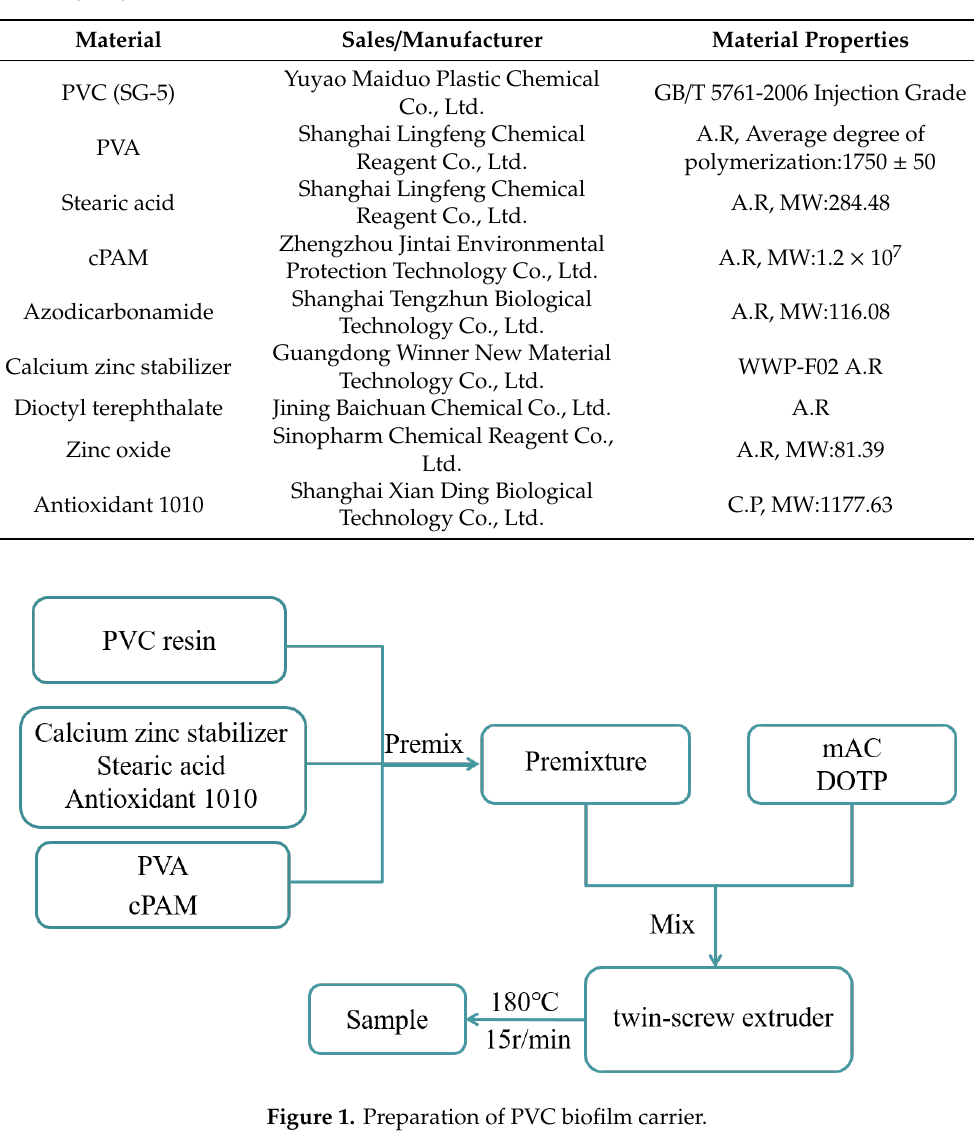
Table 1. The information of the materials. cPAM: cationic polyacrylamide, PVA: polyvinyl alcohol, PVC: Polyvinyl chloride.